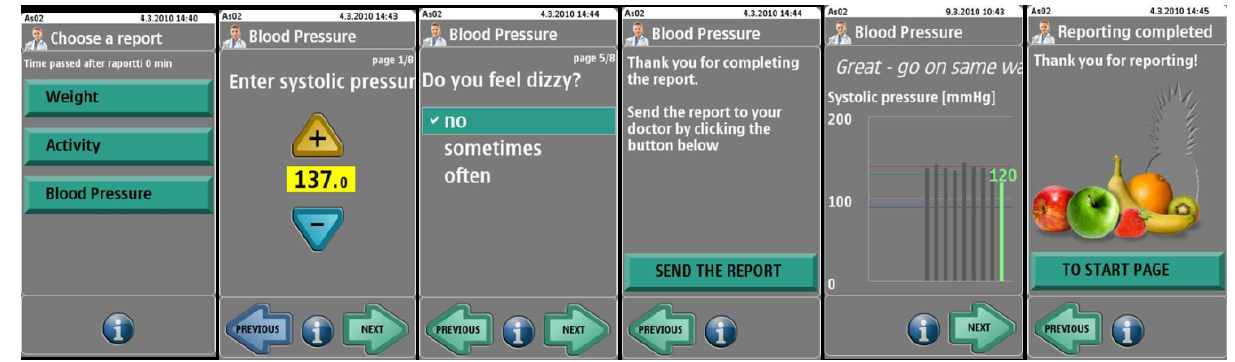
Figure 2. Screenshots of the reporting process with the mobile